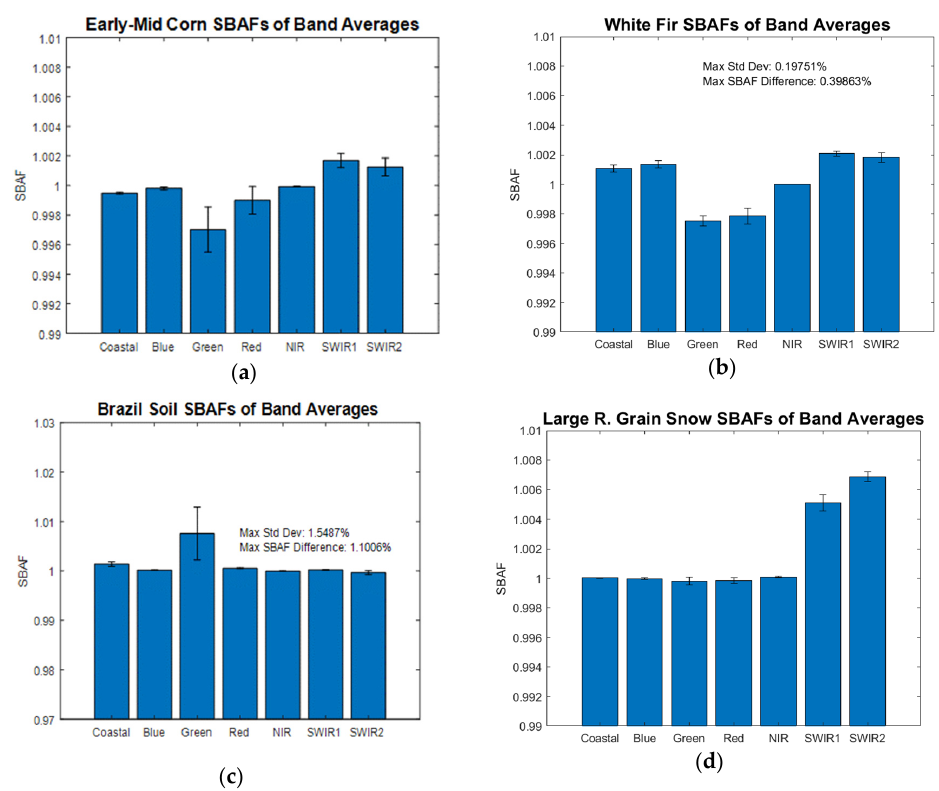
Figure 2. SBAFs for all OLI band averages for four common land cover types. ( a ) is mid ‐ season corn, ( b ) is White Fir, ( c ) is Brazilian soil with similar results to that of a desert, and ( d ) is large rounded grain particles of snow.